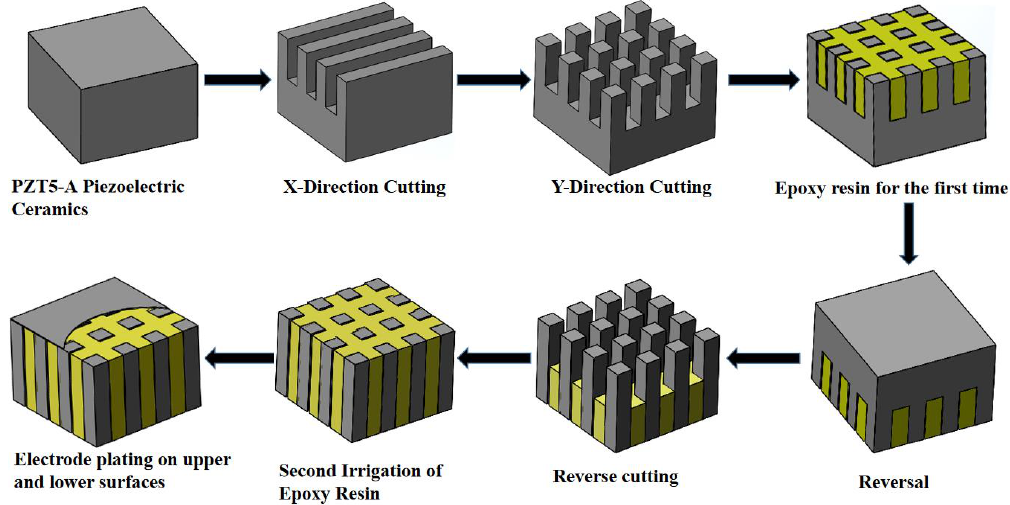
Figure 7. Fabrication process of the piezoelectric composites.